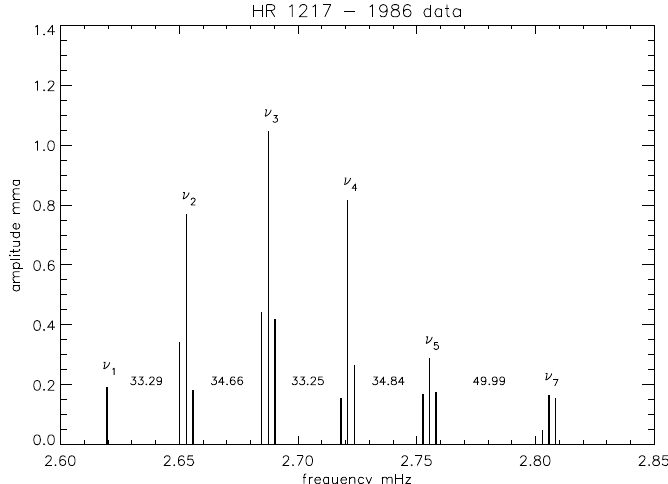
Fig. 5. A schematic amplitude spectrum for the 1986 HR 1217 data. The frequency separations are given in μ